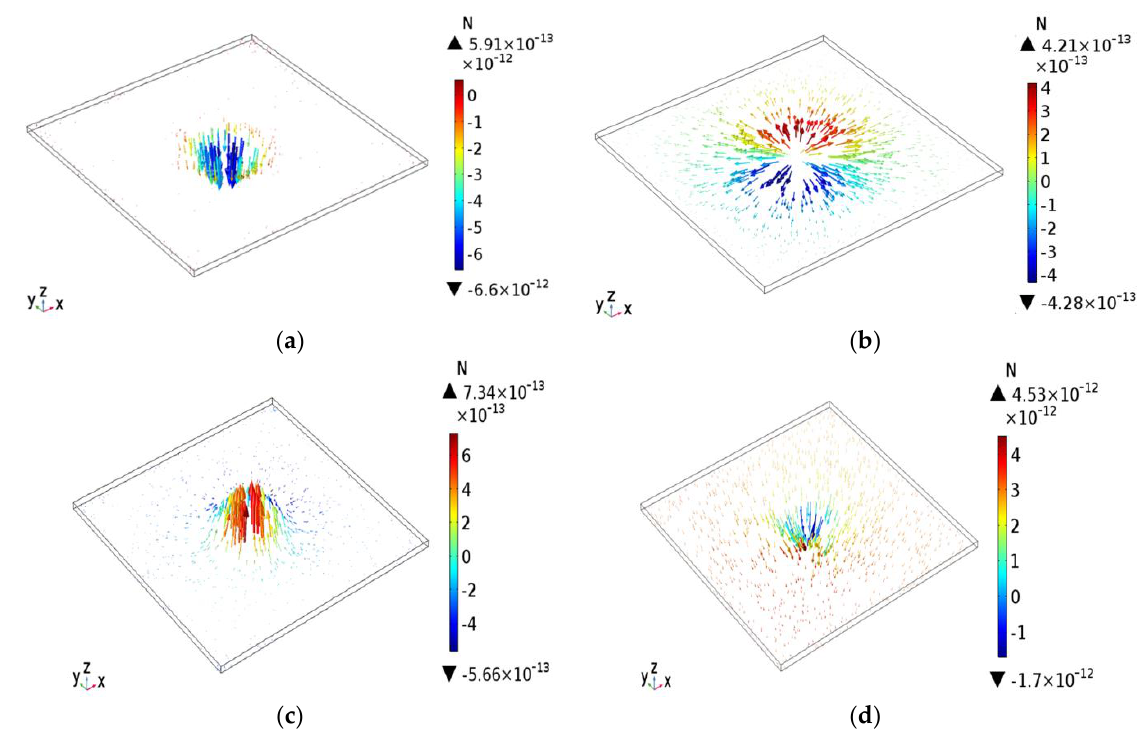
Figure 3. Numerical results for distributions of: ( a ) DEP force, ( b ) thermophoresis force, ( c ) drag force, and ( d ) trapping force acting on 11- μm particles. Note that the laser power is 75 W/cm 2 , the voltage amplitude is 35 V pp , and the driving frequency is 25 kHz.